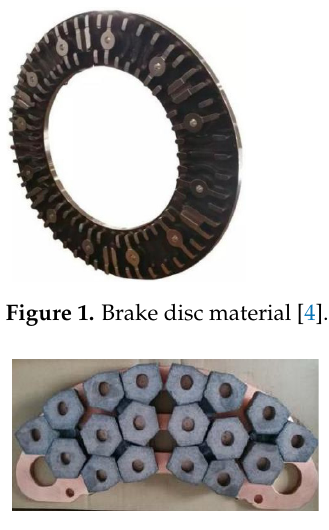
Figure 2. Brake pad material [4]. Table 1. Chemical composition of brake disc/brake material (wt/%).